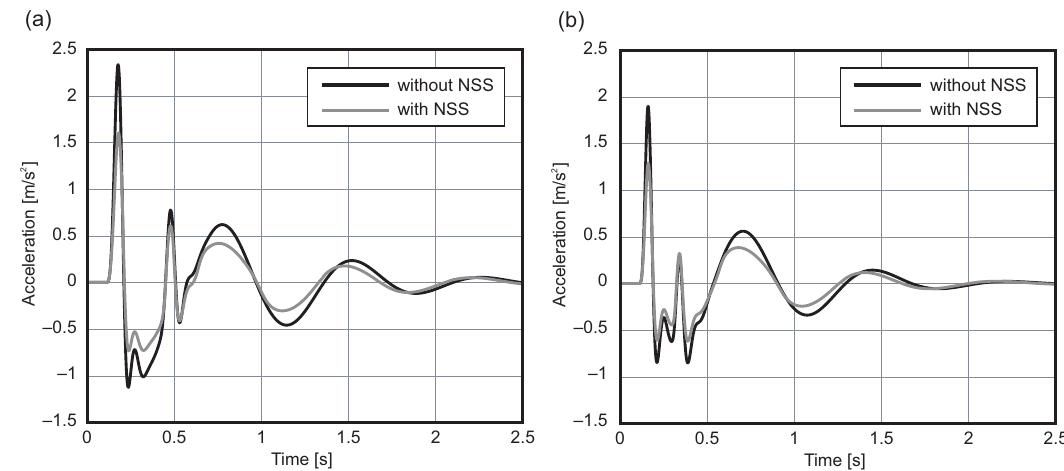
Figure 11. Acceleration values when traversing a speed bump with a mass of 75 kg at ( a ) 30 km/h and ( b ) 50